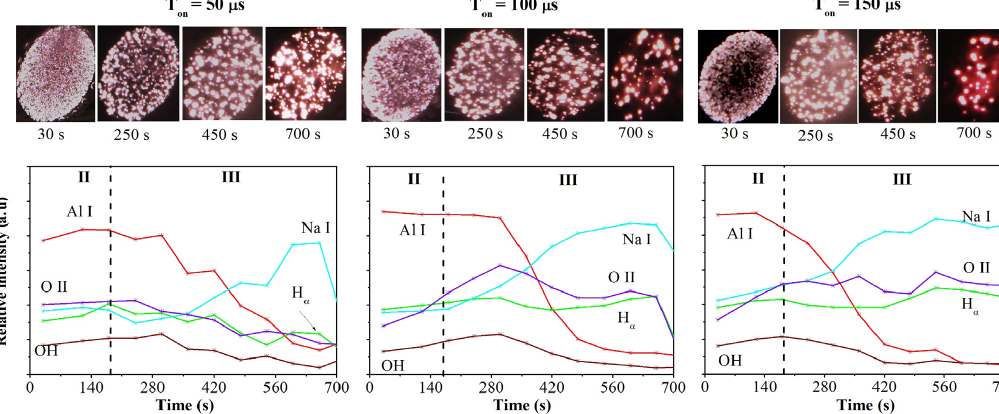
Figure 3. Evolution of the micro-discharges and intensity of the peaks of the chemical species with PEO treatment time on stages II and